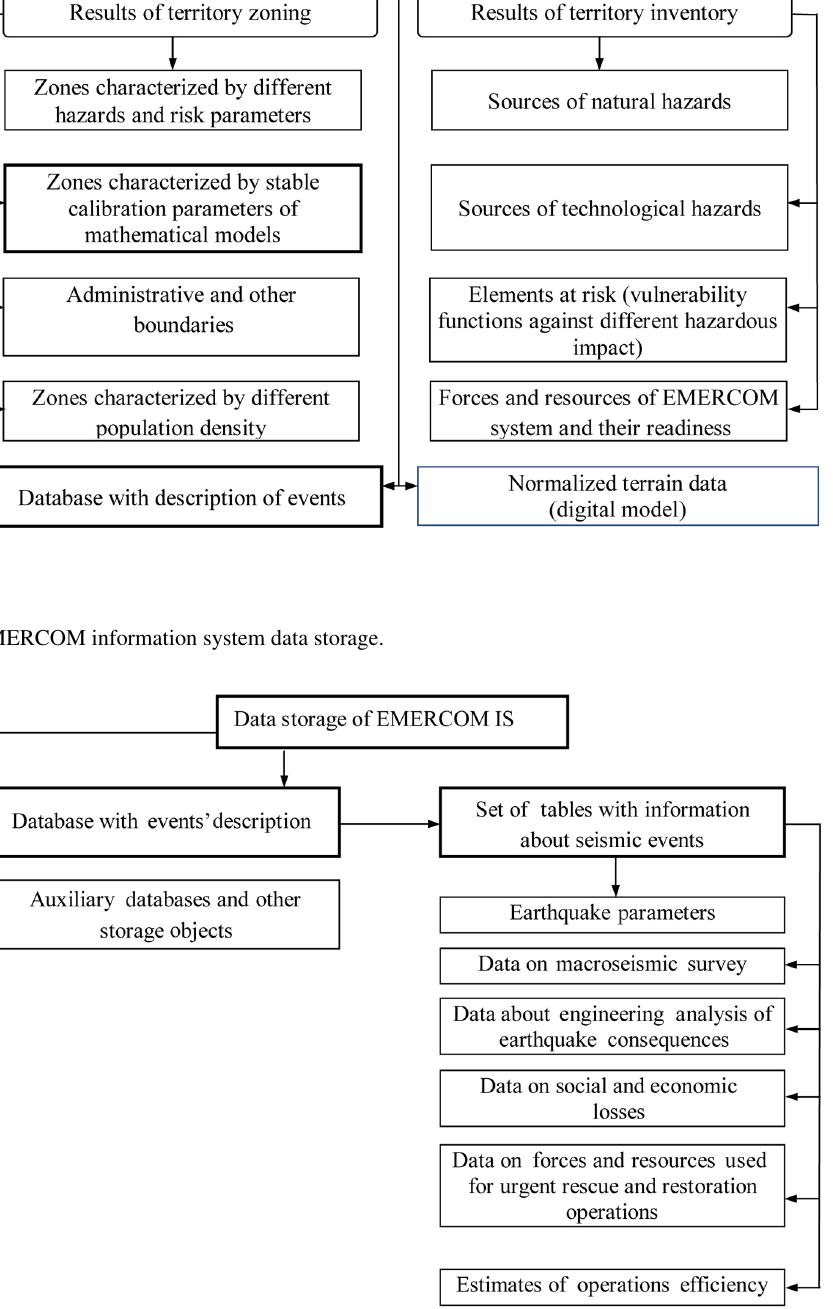
Figure 3. Database on event tables with earthquake